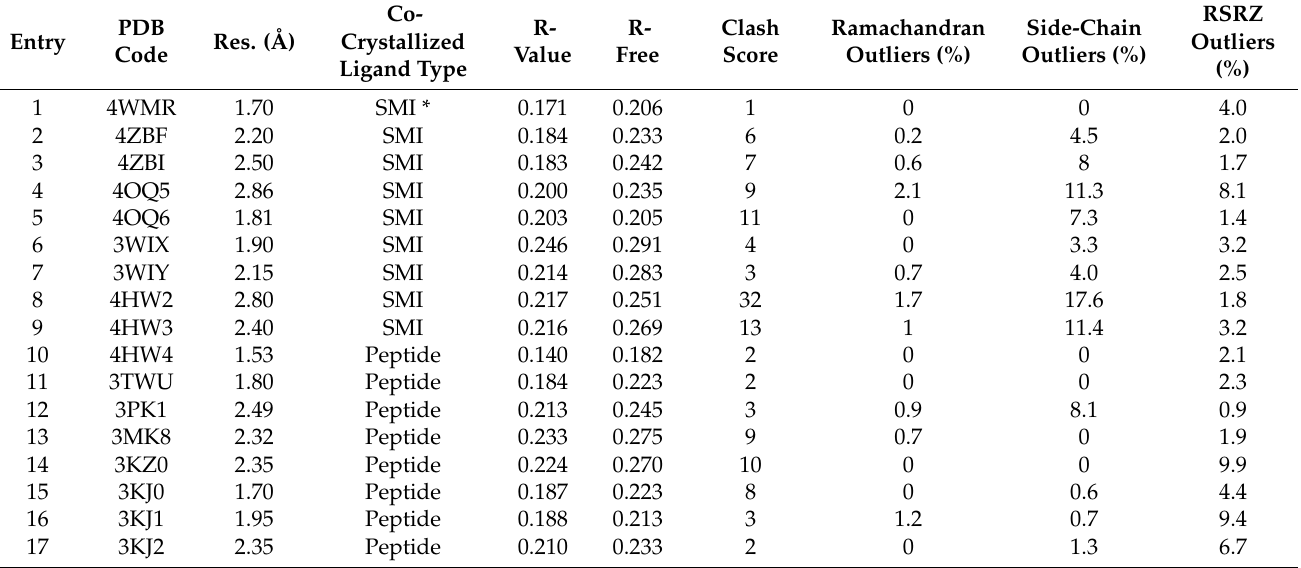
Table 1. Parameters of co-crystal structures from the protein databank where hMcl-1 binds to a ligand